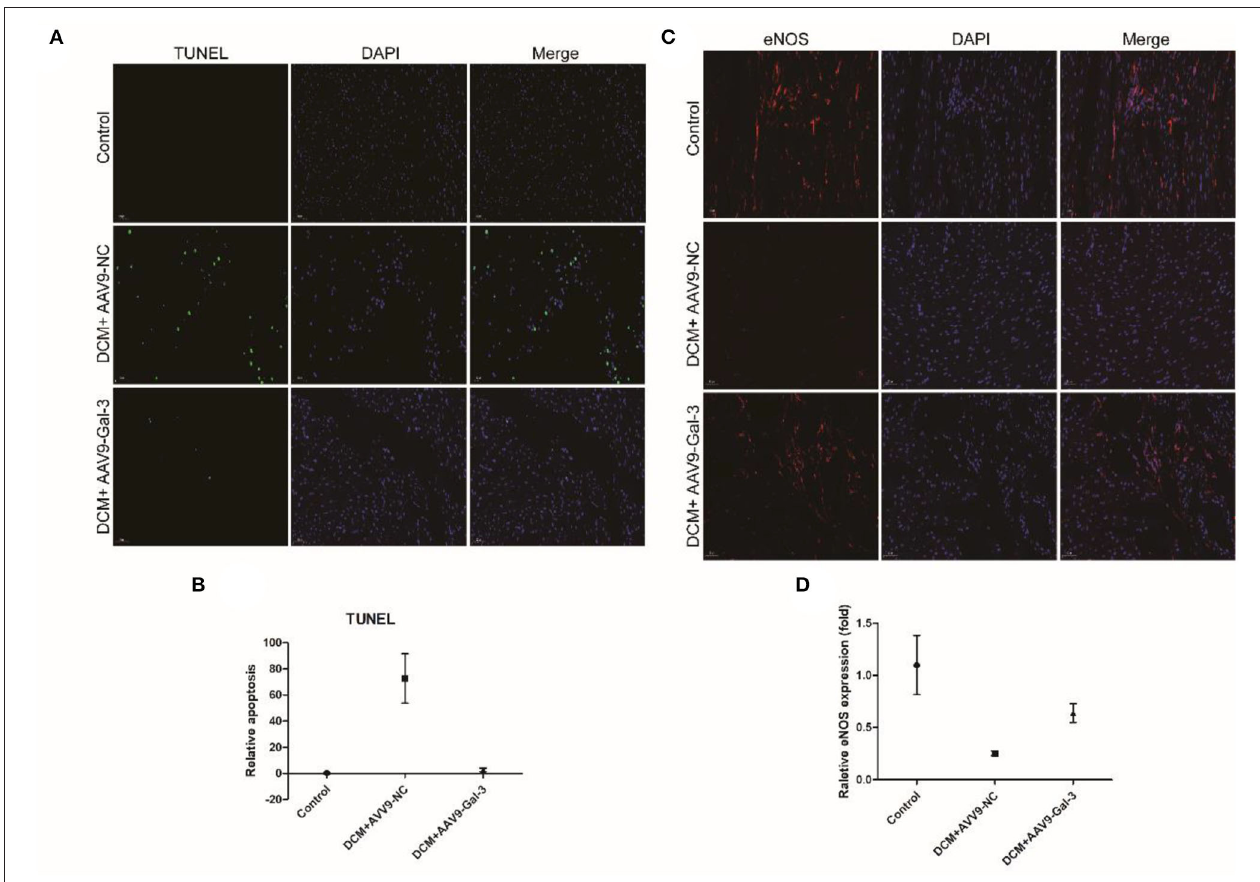
FIGURE 4 | Gal-3 inhibition reduced diabetes-induced apoptosis and oxidative stress (A,B) TUNEL and (C,D) immunofluorescence staining of eNOS in heart tissue at 16 weeks after STZ injection. Data are shown as mean ± SD. n = 3, * P < 0.05 vs. Control; # P < 0.05 vs. DCM +